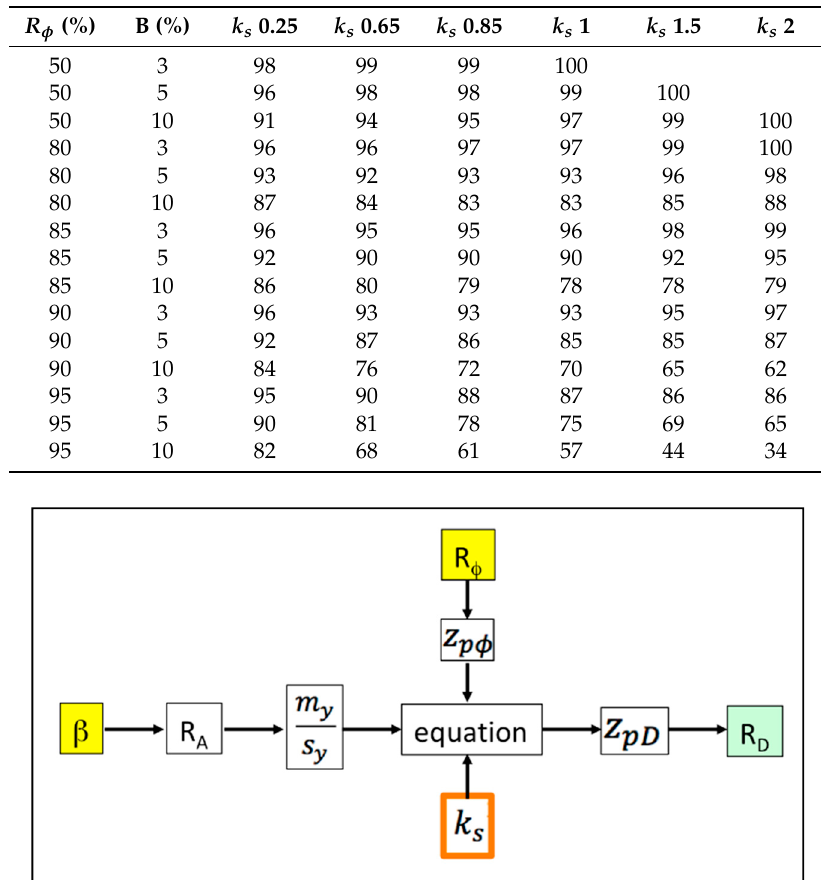
Table 3. Values of hydraulic cylinder resistance reliability R D .